Question: What does this figure show? Answer in one sentence.
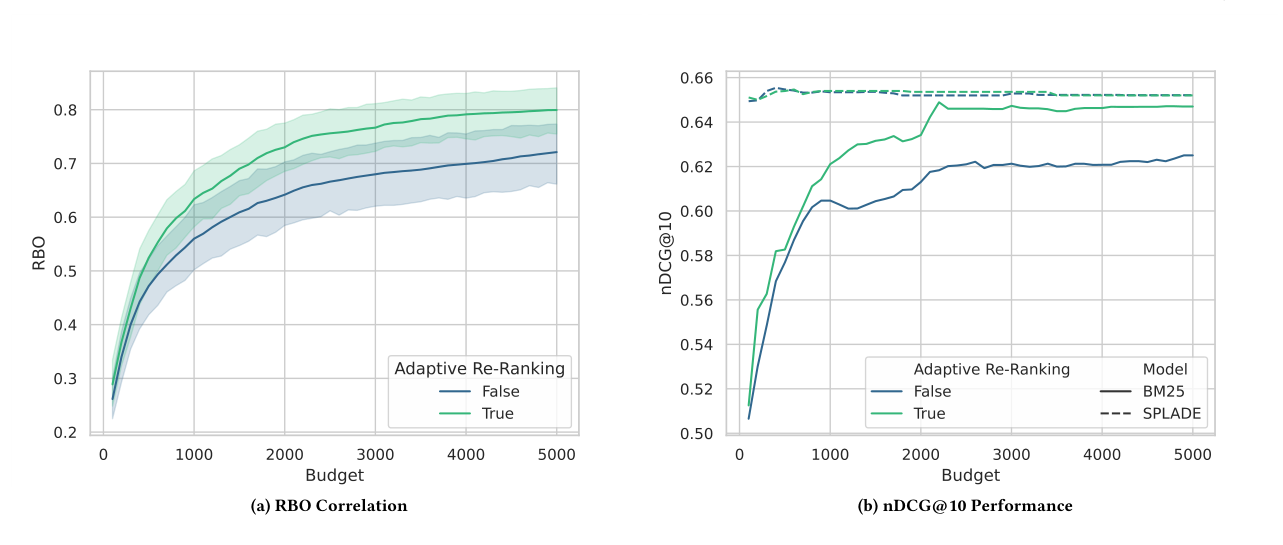
Answer: Contrasting adaptive re-ranking over BM25 and SPLADE first stages with full re-ranking at different budgets on TREC Deep Learning 2022 queries. Rankings are truncated to the top 100 results. Post-ranking, duplicates were added to the rankings to follow the current TREC procedure on MS MARCO-v2. Error bands are omitted from Figure (b) for clarity.